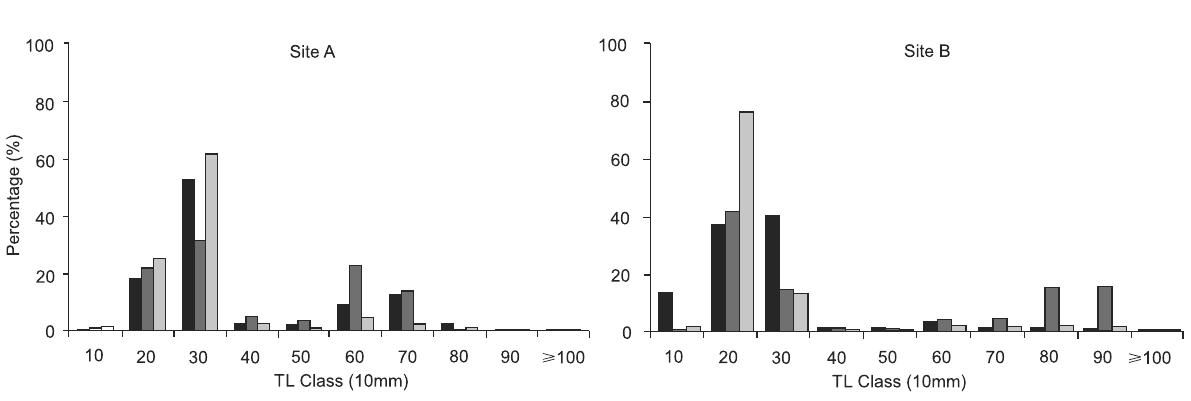
Figure 5. Percentage of individuals captured by length class for each haul distance (50, 70 and 100 m), for each sampling site (A and B). ( (cid:132) ) 50 m, ( (cid:132) ) 70 m, ( (cid:132) ) 100 m.